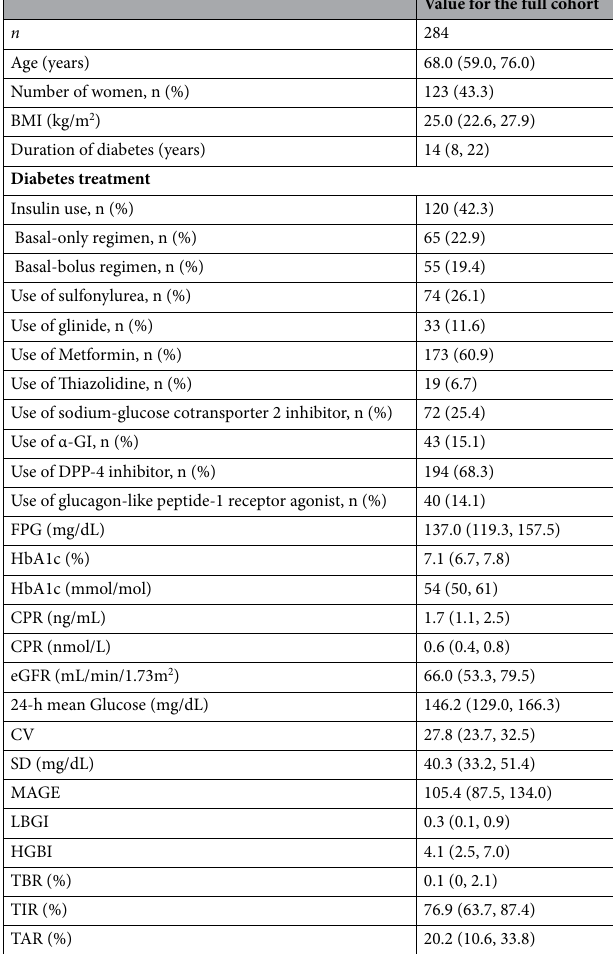
Table 1. Characteristics of the participants. Values are expressed as median (interquartile range), or number (%) of participants in each category. BMI body mass index, α-GI alpha-glucosidase inhibitor, DPP-4